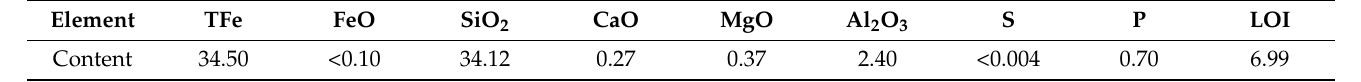
Table 1. Analysis of the chemical composition of the limonite ore (mass,